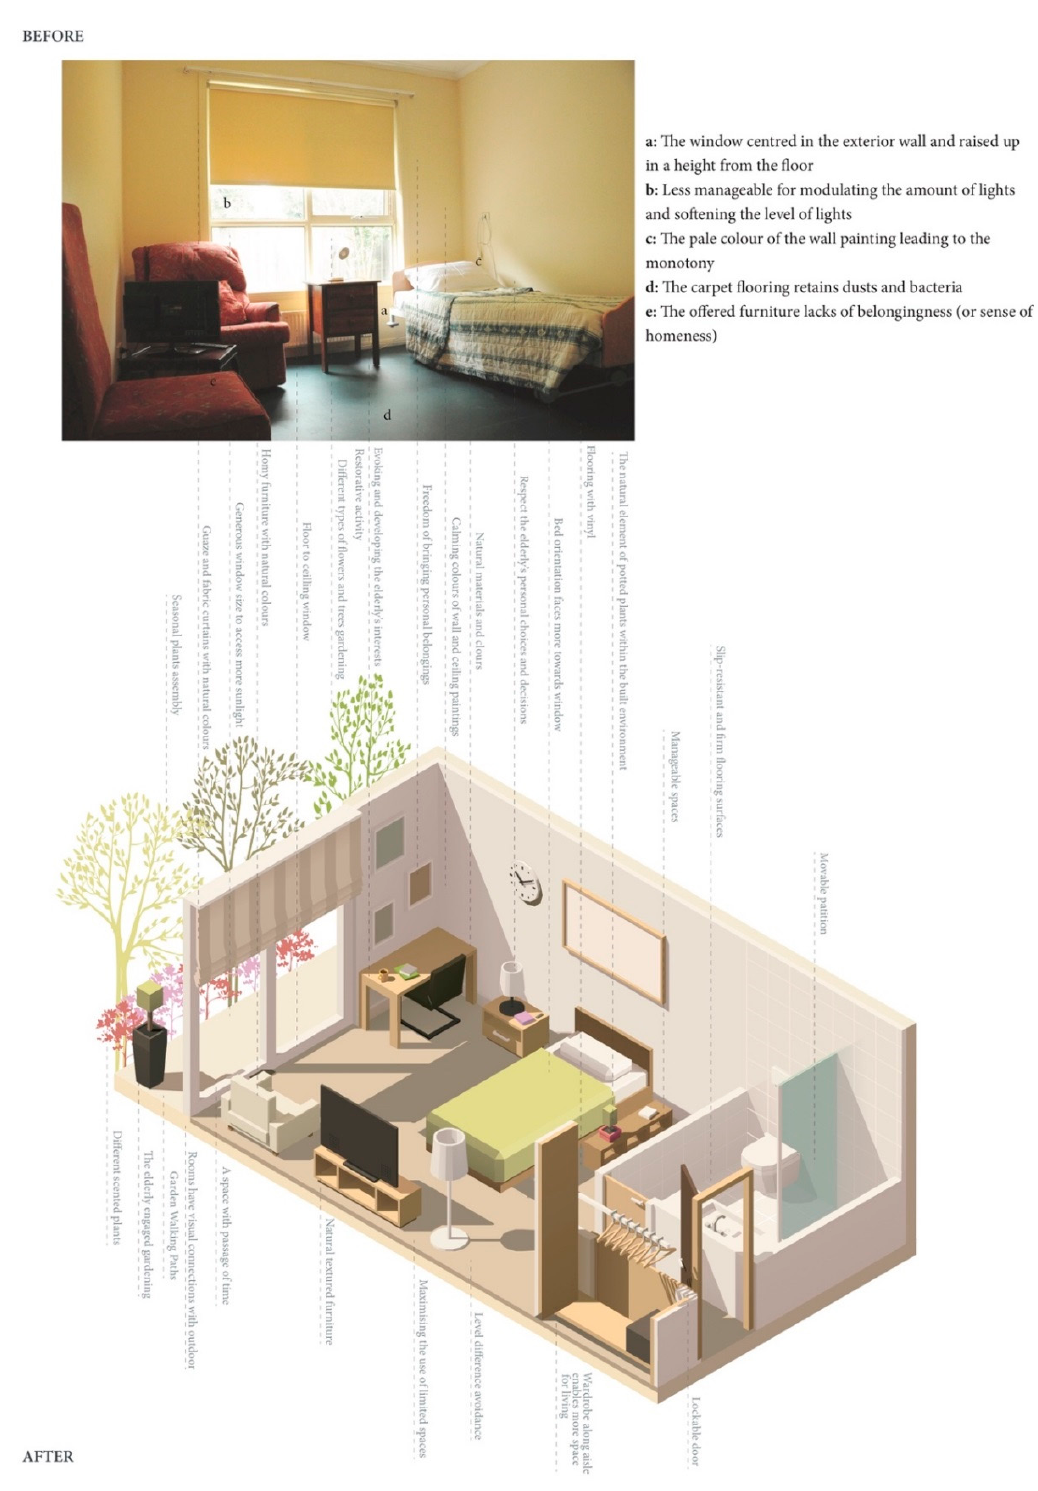
Figure 9. An existing bedroom unit ( top ) and the EXD upgrading potentials ( bottom ).